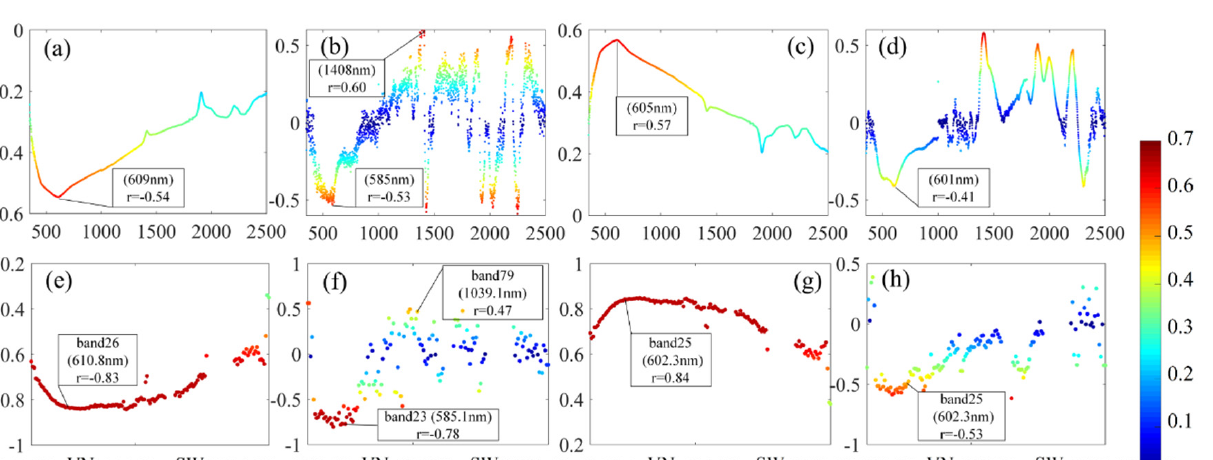
Figure 10. The RPR value of different number of LVs for 4 models with different forms of spectra: ( a ) indicates the model based on Spectral reflectance (R); ( b ) indicates the R’ model; ( c ) indicates the ln(1/R) model and ( d ) indicates the CR model. Axis X indicates the number of LVs for modelling. Axis Y indicates the RPR value. For the models derived from the same spectral form, the same number of LVs were employed for modelling to keep the spectral region as the unique variable for comparative